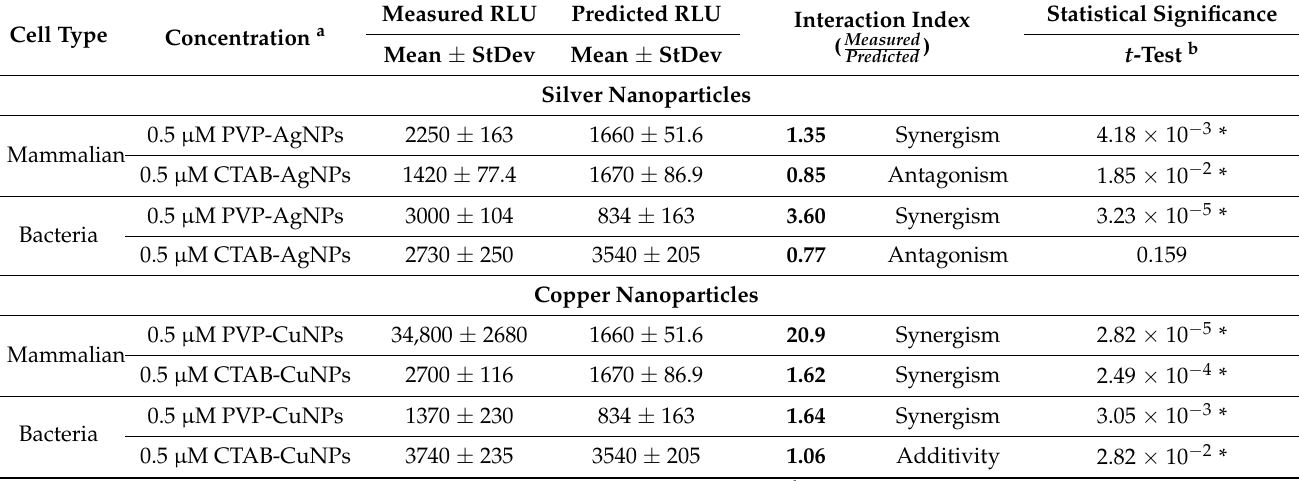
Table 1. Summary of chemical-interaction analyses of nanoparticle components. ROS generation, measured by relative luminescence units (RLU), by mammalian and bacterial cells after exposure to surface-coated nanoparticles (Measured) or their components (Predicted). Measured and predicted RLU values and interaction indices against mammalian (BEAS-2B) and bacteria ( E. coli ) cells of each nanoparticle used in this study as compared to the individual constituents of the nanoparticle construct. Four types of nanoparticle constructs were tested, PVP-AgNPs, CTAB-AgNPs, PVP- CuNPs, and CTAB-CuNPs. Each RLU value was recorded from the assay measuring the reactive oxygen species. The table includes the analyses of effects after inoculation with 0.5 µ M (only); the data collected using the 1.0 µ M concentration produced similar results in terms of RLU values, interactions indices and statistical significance. The measured RLU value was significantly higher for PVP-AgNPs, PVP-CuNPs and CTAB-CuNPs tested in mammalian cells. The measured RLU values were significantly higher for PVP-AgNPs and PVP-CuNPs tested in bacteria